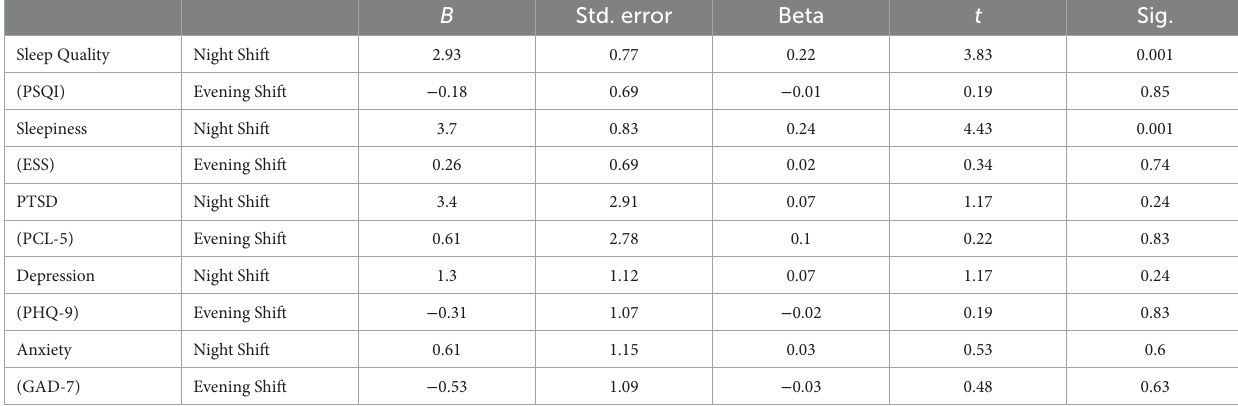
TABLE 4 Results from linear regression models testing the impact of shift type on sleep quality, sleepiness, PTSD, depression, and anxiety. B Std. error Beta t